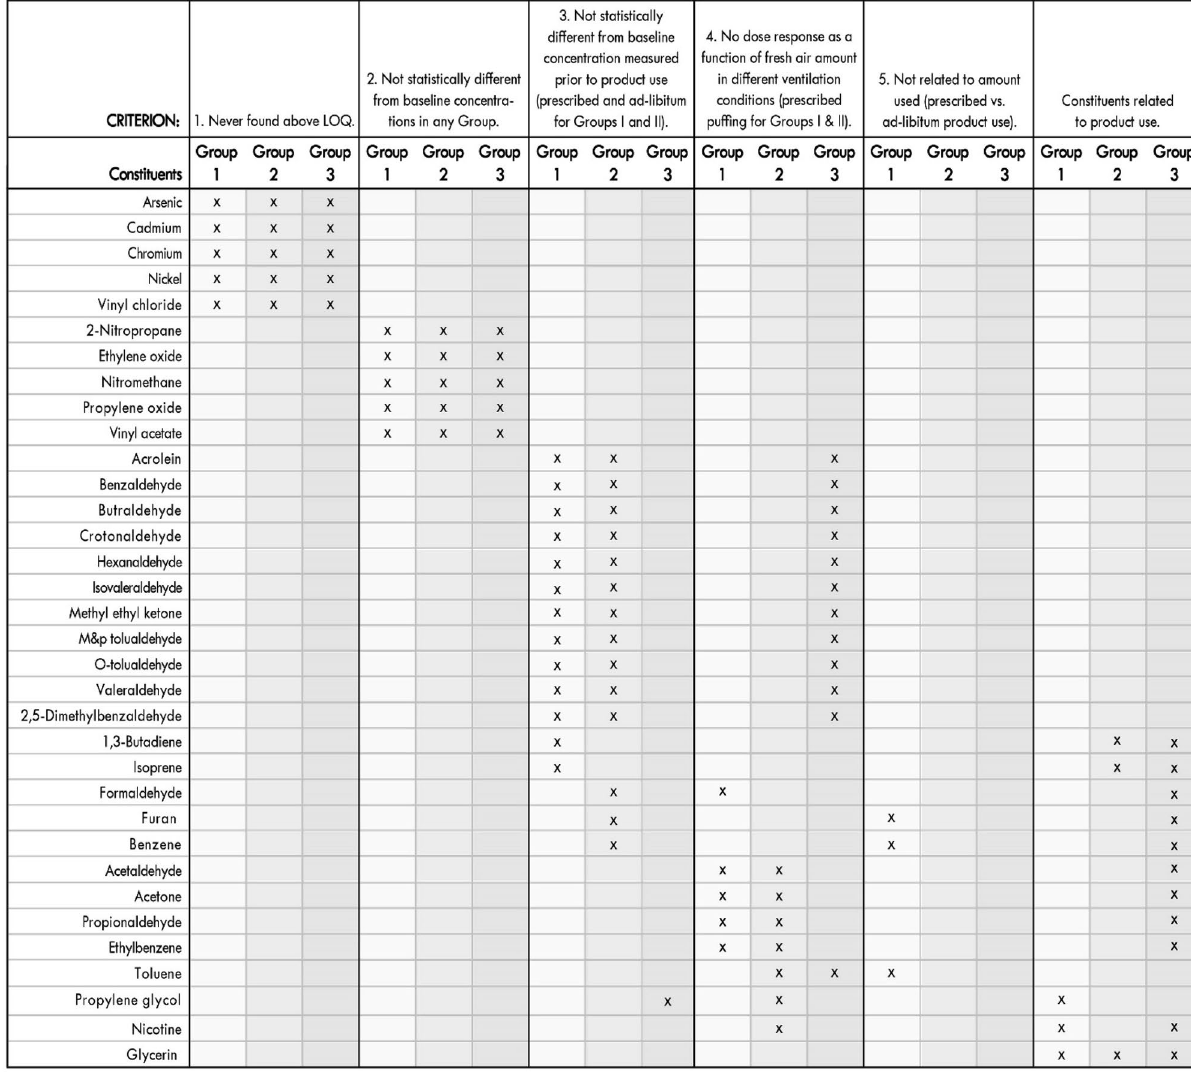
Table 6. Criteria used for deciding which measured constituents are a function of product